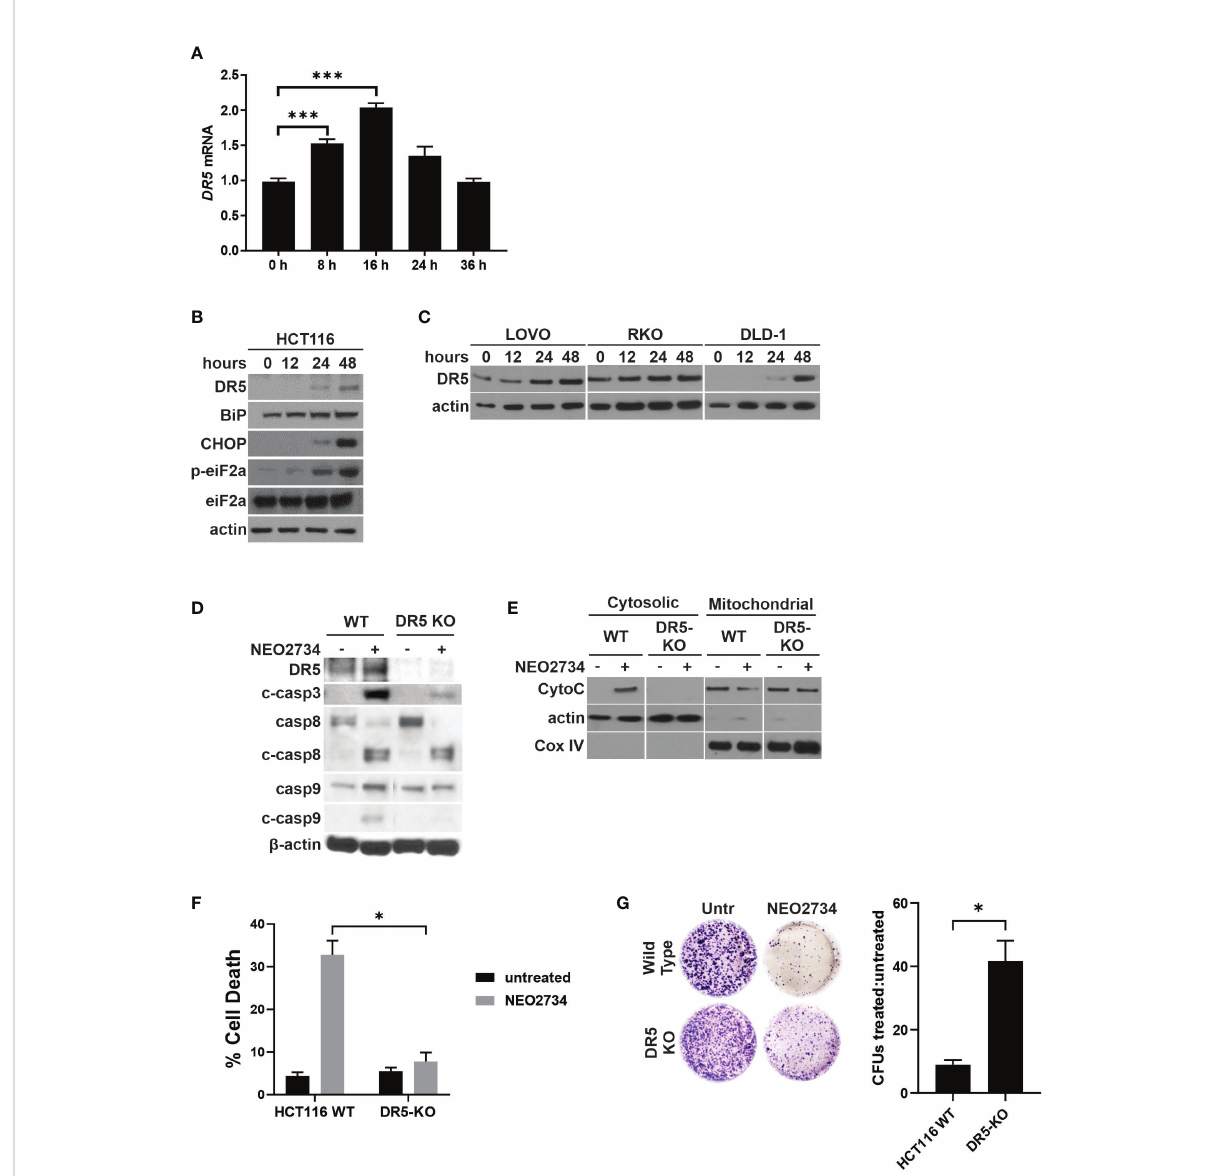
FIGURE 4 NEO2734 induces DR5-dependent apoptosis. (A) RT-PCR of DR5 in HCT116 cells treated with NEO2734 10µM for the indicated times, normalized to GAPDH. (B) Western blotting of DR5 and indicated ER stress response markers in HCT116 cells treated with NEO2734 10µM. (C) Western blotting of indicated cell lines for DR5 after treatment with NEO2734. LOVO cells were treated with NEO2734 1µM, RKO and DLD-1 were treated with NEO2734 10µM. (D) Western blot of DR5 and caspases in parental HCT116 (WT) and HCT116 DR5 -KO cells treated